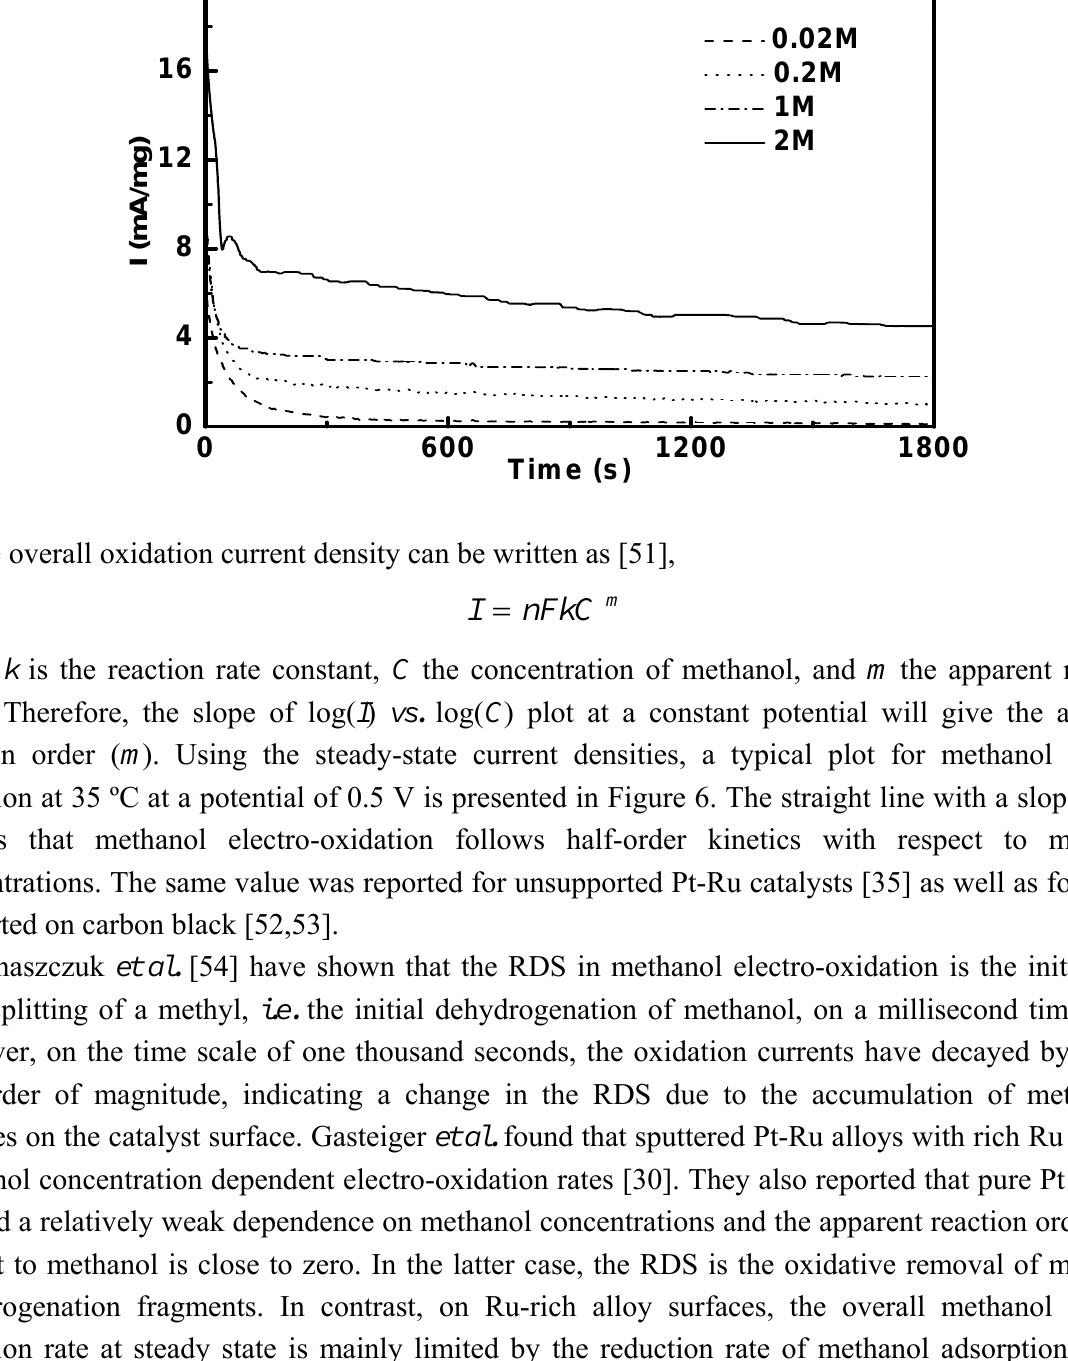
SO at 35 ºC. The applied potential is 2 4